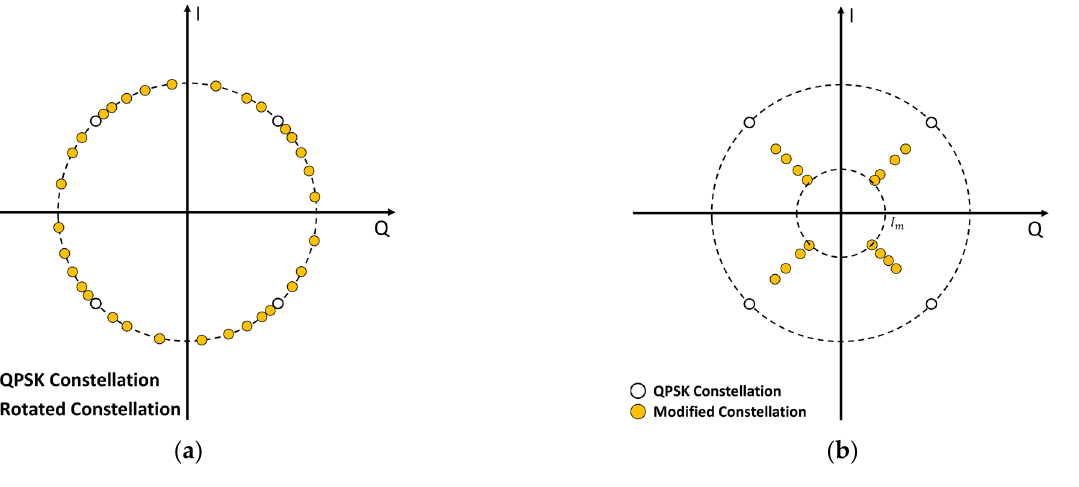
Figure 5. Ring-shaped signaling processed I/Q constellation ( a ) only affected by phase-modifying factor and ( b ) only affected by magnitude-modifying factor.